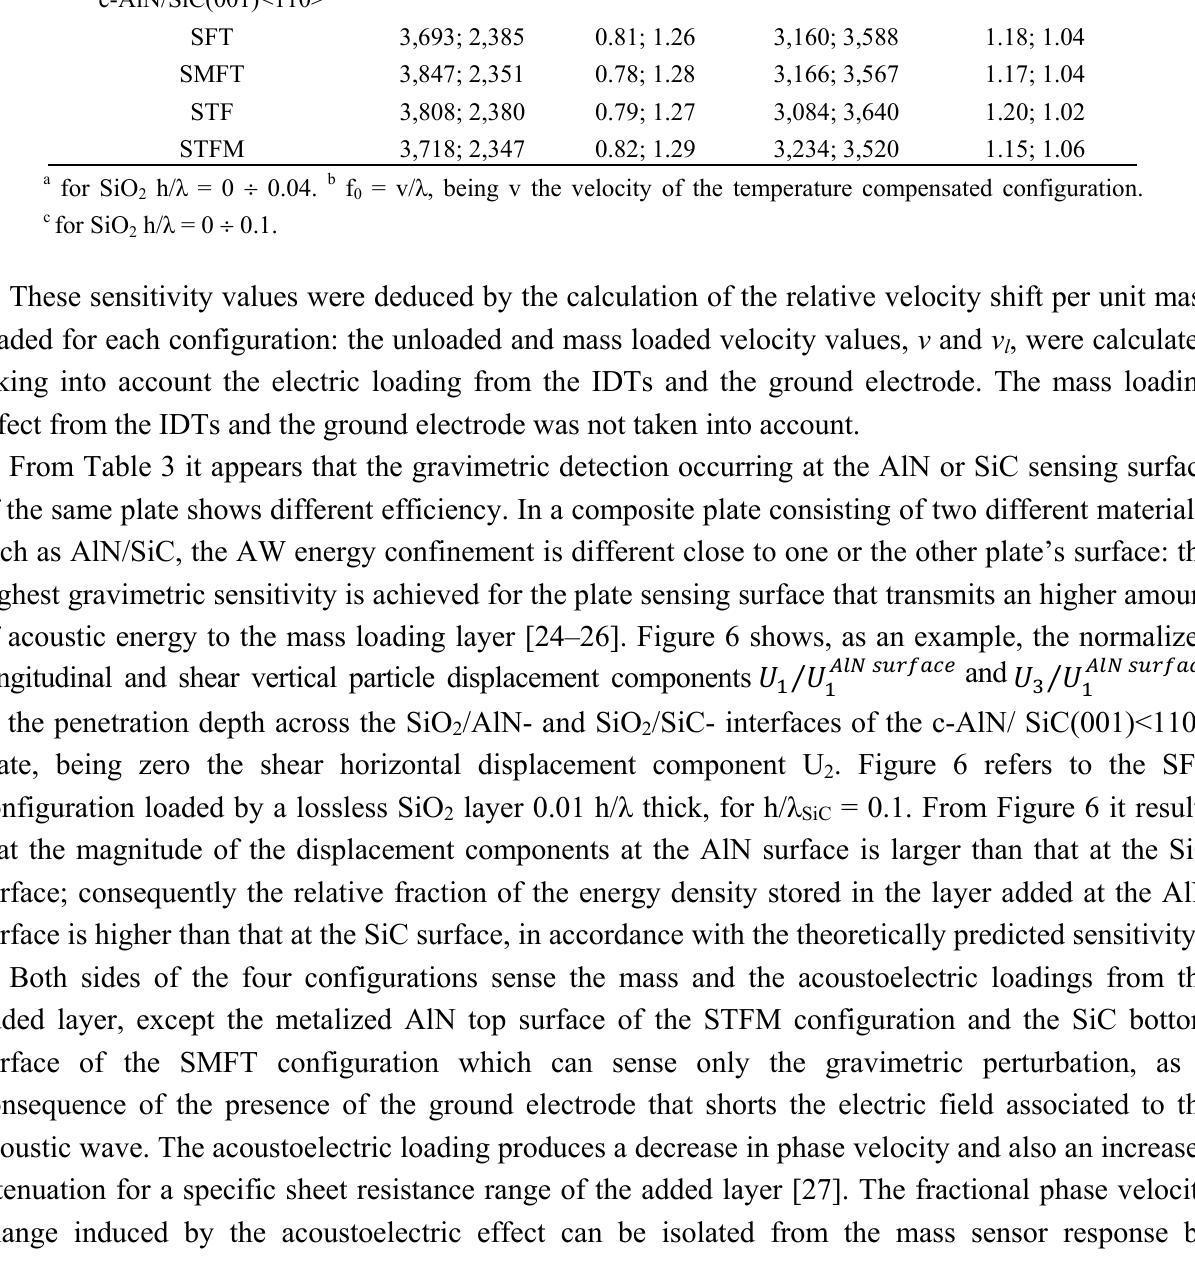
Table 3. The gravimetric sensitivity S temperature compensated coupling configurations loaded on the AlN or SiC surface with a SiO film; λ (µm) is the numerical value of the acoustic wavelength expressed in µm. 2